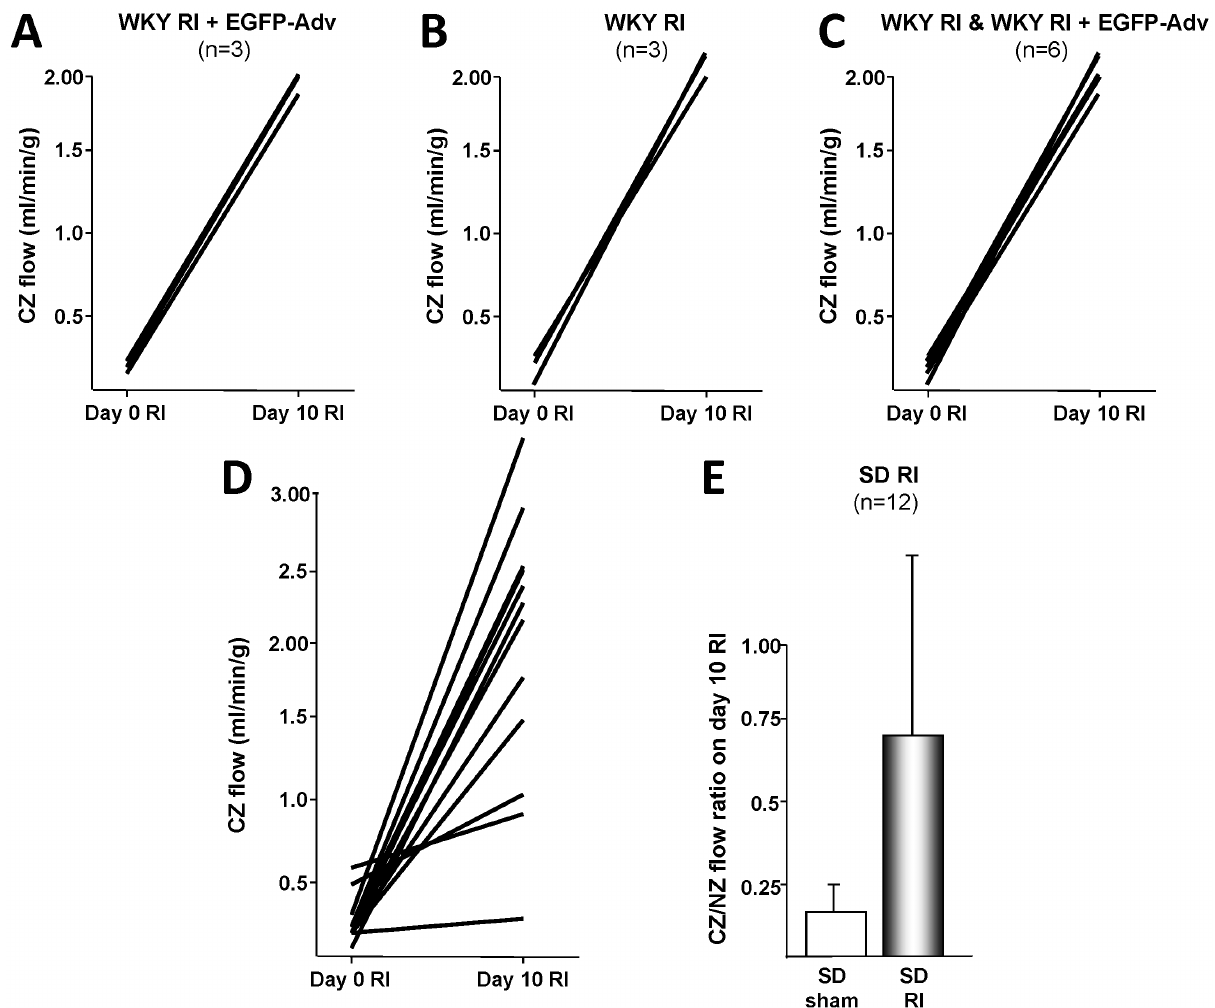
Figure 7. Collateral dependent blood flow measurements made after transient repetitive myocardia ischemia (RI) studies using the automated balloon catheter inflation device described in this manuscript displayed greatly reduced variance compared to blood flow measurements made after transient ischemia using manual inflation. Blood flow measurements made in WKY rats after using the automated inflation device (A–C) not only displayed greatly reduced variance than our previous manual inflation studies (compare to Figure 2 in Toyota, et al., 2005) [23], but also required fewer animals to complete a similar study (n=3 or n=6, compared to n=9, for a study group). Note that panel C represents data from panels A and B combined. Similarly, blood flow measurements made in SD rats after manual inflation (D, E) had such high variance that they were not statistically significant (even with an n=12), while measurements made after automated inflation (compare to Figure 7 in Dodd, et al., 2011 and Figure 4C in Hutcheson, et al., 2013) [24] achieved a high level of significance (p , 0.05) with fewer animals (n=5 and n=7, respectively). A summary of results with coefficients of variation is given in Table 1.